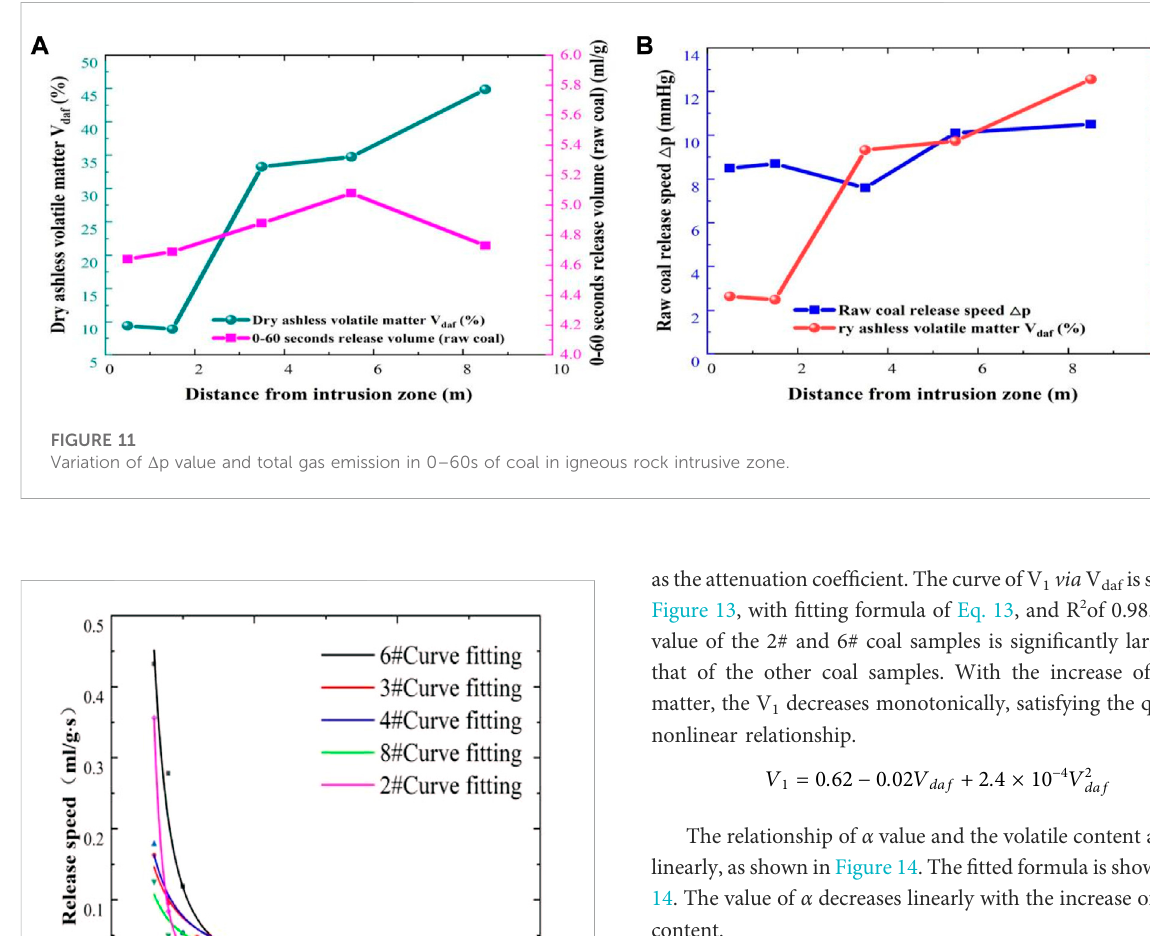
The relationship of α value and the volatile content are fi tted linearly, as shown in Figure 14. The fi tted formula is shown in Eq. 14. The value of α decreases linearly with the increase of volatile content.